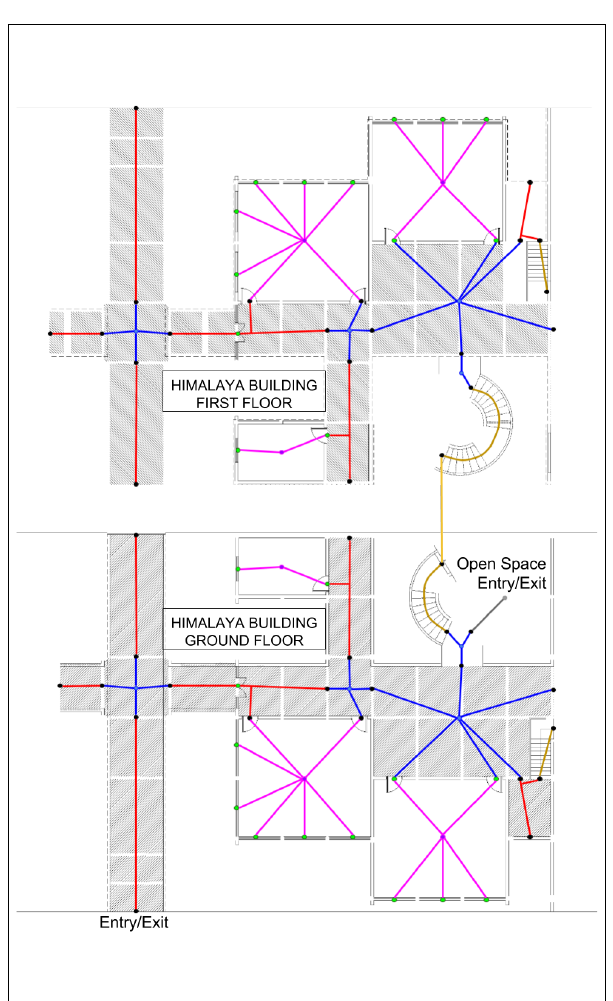
Table 1: The set of features and the grammar of the defined properties.